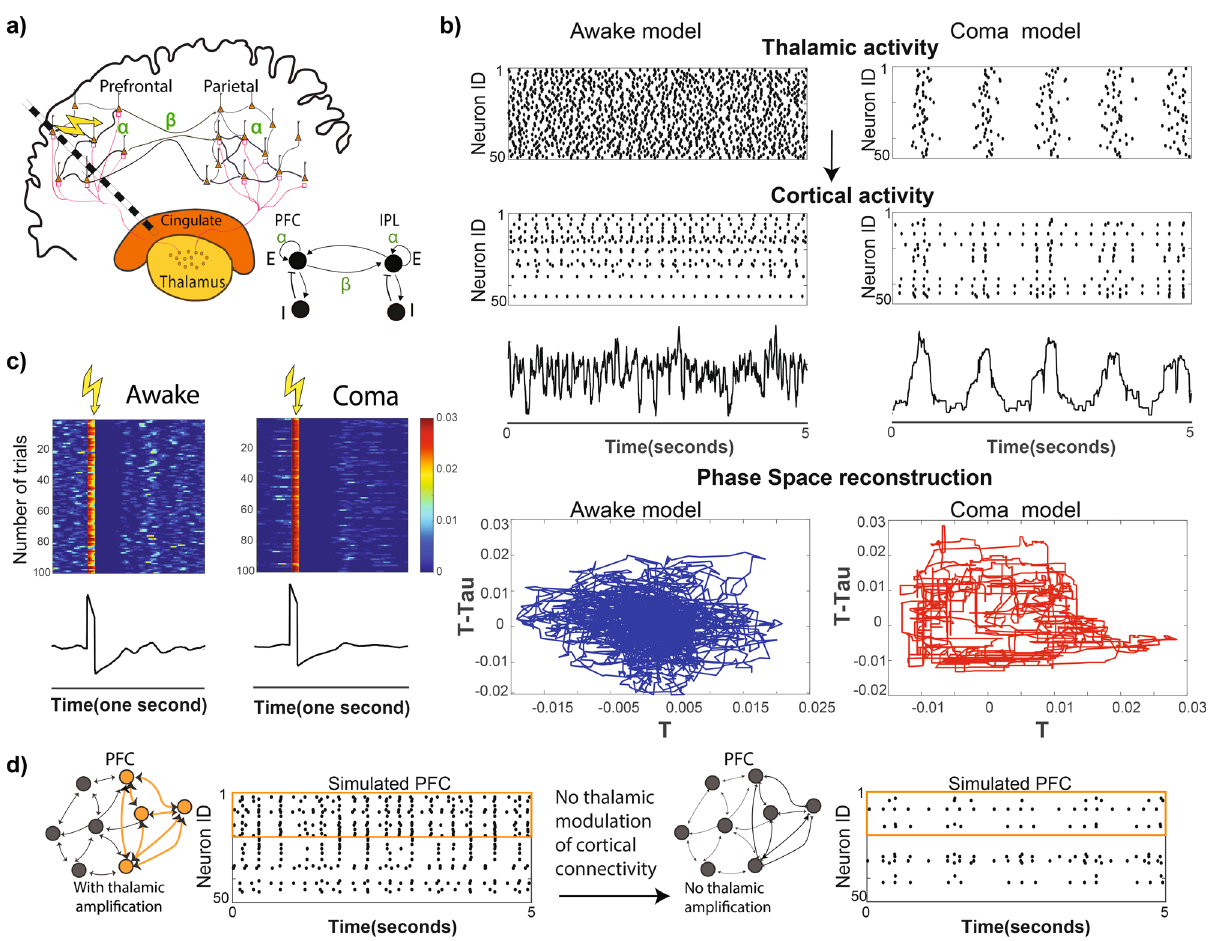
Fig. 4 The computational model of thalamocortical networks in consciousness predicts content of consciousness requires thalamic modulation of cortical networks. a The thalamocortical model consists of two interconnected cortical populations that receive thalamic input. Each cortical region includes interacting excitatory and inhibitory cells. In addition to the excitatory input, the thalamus modulates the local ( α ) and long-distance ( β ) connectivity of cortical networks. b Depending on the activity mode of thalamus (tonic vs. phasic) cortical cells switch between rhythmic (coma) and asynchronous (awake) dynamics. The reconstruction of phase space for awake and coma shows a structured phase space for coma and much more complex phase space for the awake state; similar features are seen in the experimental data. c The evoked responses for 100 simulated trials of coma and awake states are shown in heat maps for a one-second period where the color intensity denotes the de fl ection from the baseline. Underneath the heat map, the average of these responses across one hundred trials is shown; the stimulation time is marked by the yellow lightning bolt. Note that stimulation in the simulated awake state triggers multiple waves of excitation. Stimulation in coma results in a monophasic, and stereotypical response. d In our model, an embedded cortical cluster (i.e., an ensemble, orange bracket on raster plots) only becomes activated when it receives both excitatory thalamic input and ampli fi cation of its cortico − cortical connections (left versus right raster plots). This ensemble represents a low-level “ building block ” of